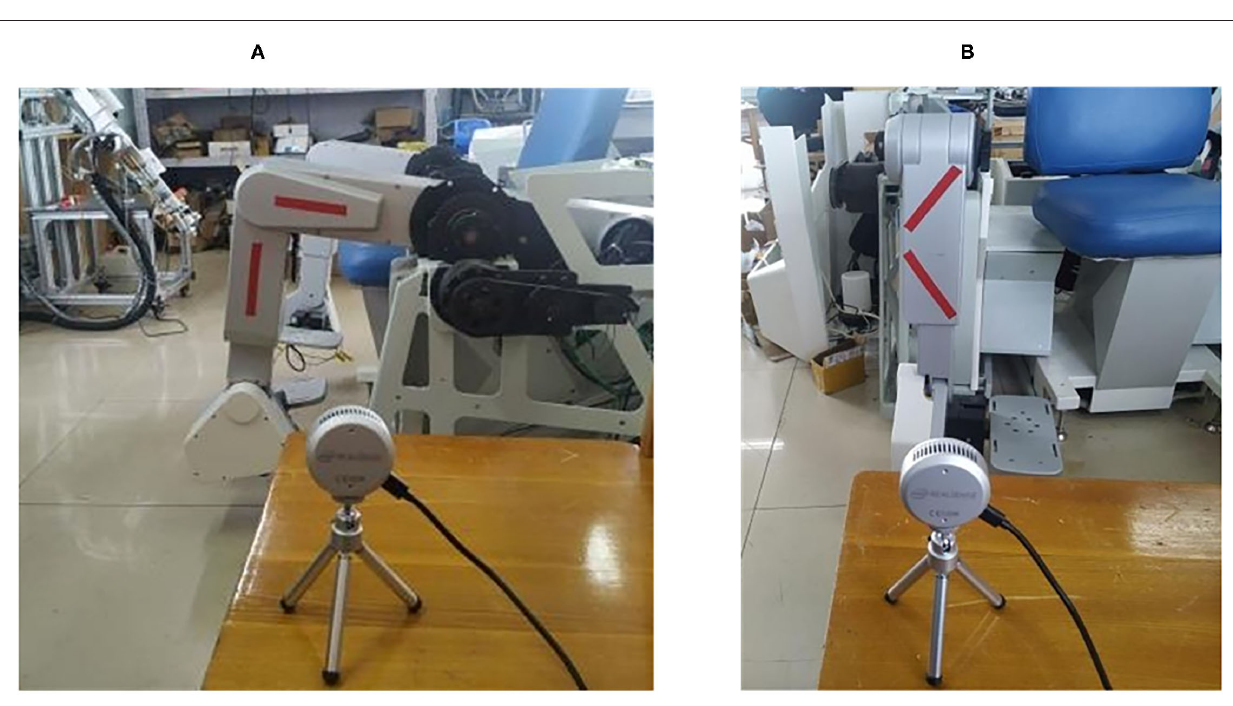
The method of measuring the hip joint range of motion in the coronal plane is essentially based on the plane fitting of two line-markers with a certain angle. At first, the acquired fitting plane is used as the measurement base plane; as the measurement continues, the angle between the new fitting plane and the measurement base plane is obtained again, that is, the solution representing the hip joint range of motion in the coronal plane. The designed joint range of motion detection system also uses